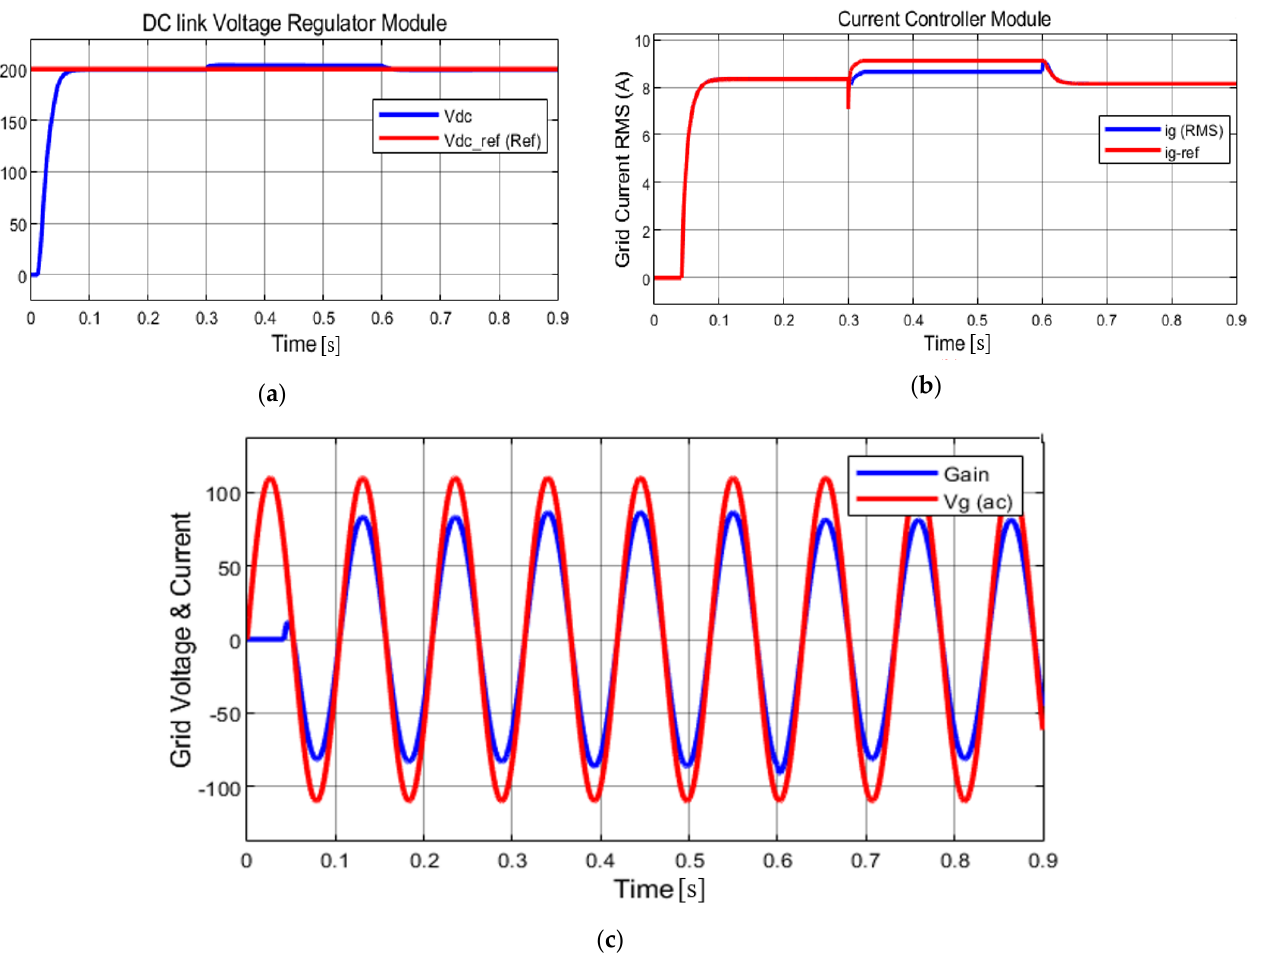
Figure 17. DC link voltage regulator module and current controller module performances with backstepping approach for constant solar irradiation case: ( a ) DC-link voltage; ( b ) grid current magnitude; ( c ) grid voltage waveform V g (V) and current waveform where gain is 10 × Ig ( A )